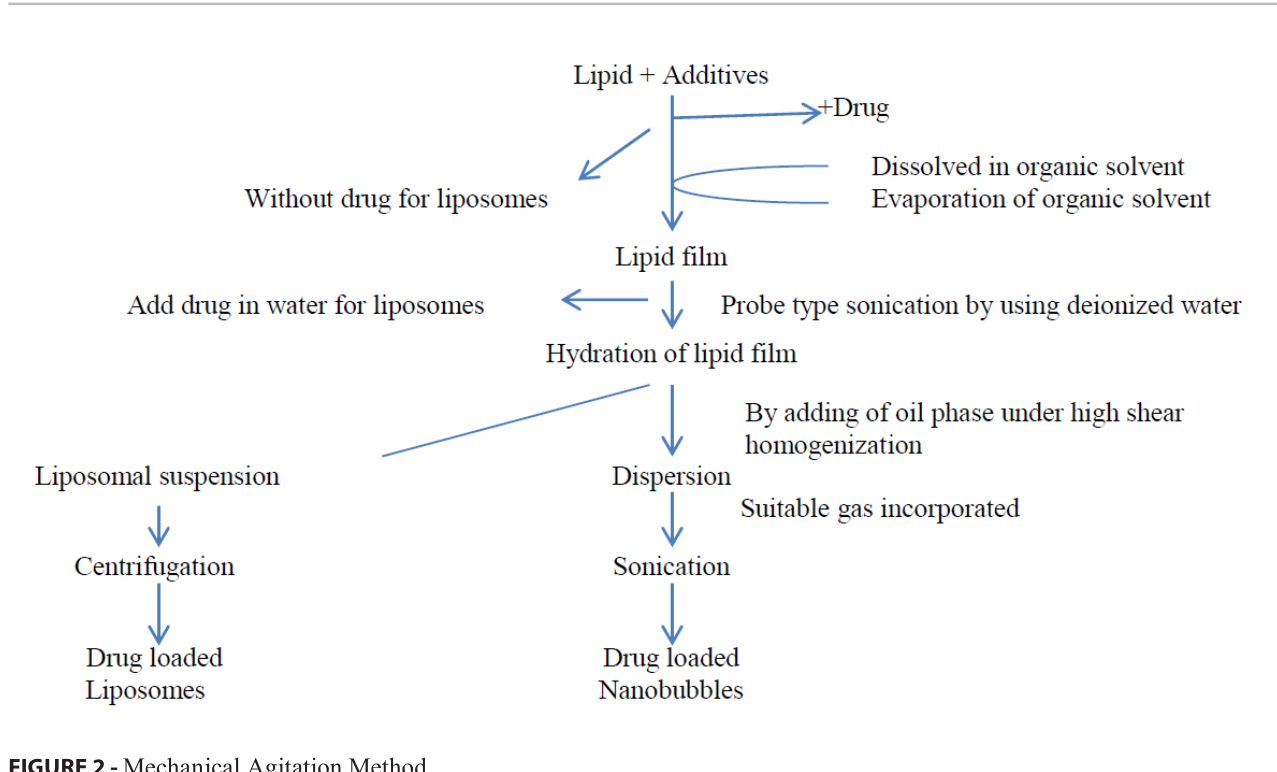
FIGURE 2 - Mechanical Agitation Method.